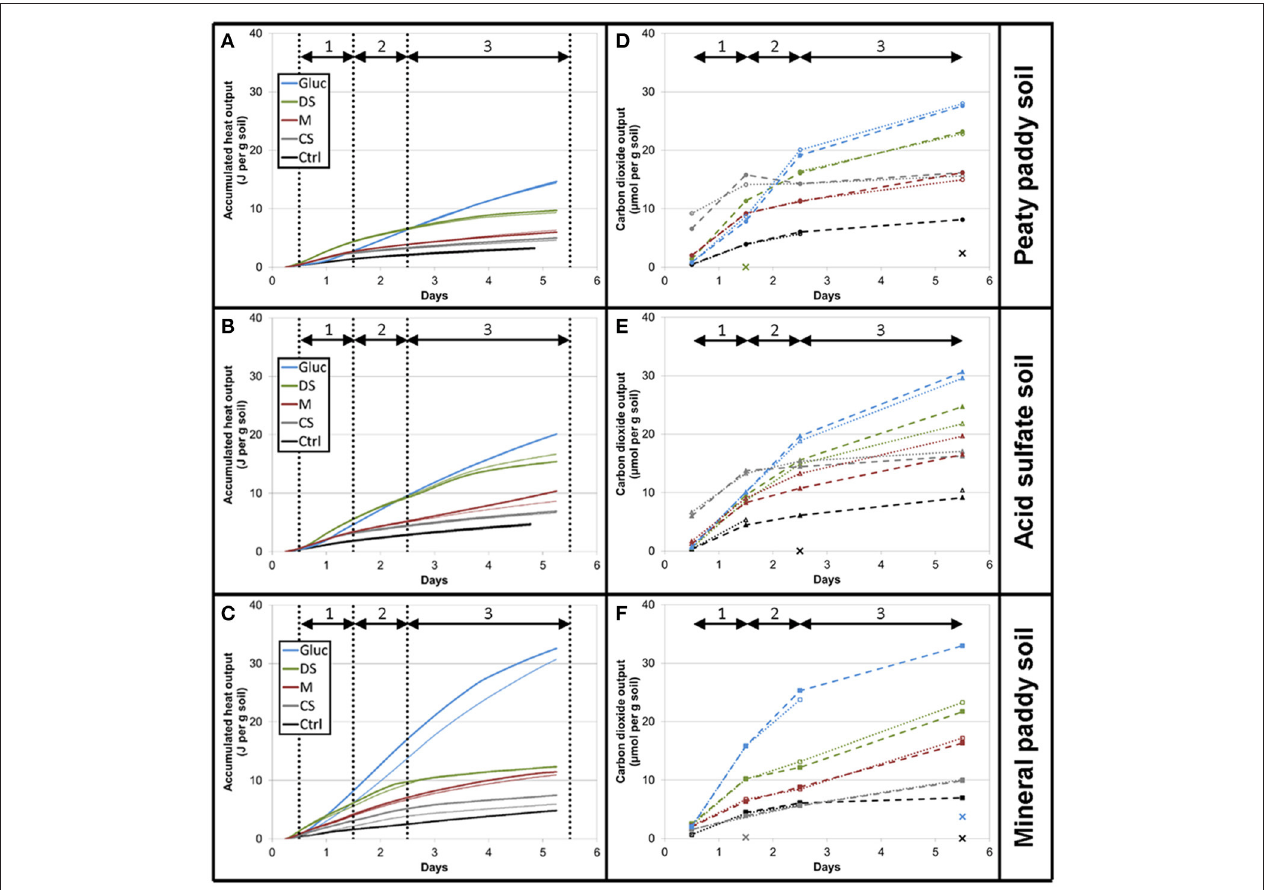
FIGURE 1 | Cumulative heat output (A–C) and respiration (D–F) for the first 5 days after flooding. Soils from top to bottom: peaty paddy soil (A,D) , acid sulfate soil (B,E), and mineral paddy soil (C,F) . Colors represent treatments: Control, black; CS, gray; M, red; DS, green; Gluc, blue. Duplicate vials are depicted by thick and thin lines. The dashed and dotted lines in the respiration figures (D–F) are only intended as guides for the eye as sampling was made on separate vials for each time point (i.e., there is no direct connection between the vials plotted within the same series other than that they belong to the same treatment). Data points marked with X denote gas samples where the GC measurements failed. Vertical dotted lines in the heat figures (A–C) indicate sampling times for the respiration measurements. Arrows denote intervals (1–3) used for calculating rates between sampling